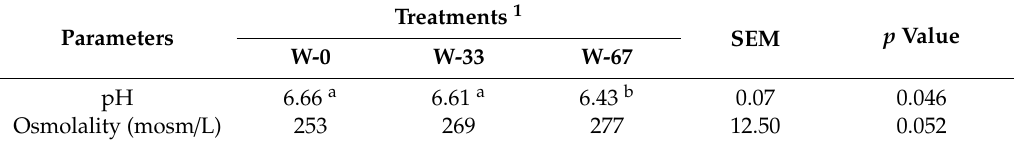
Table 5. Rumen liquor pH and osmolality in water-restricted male Najdi lambs fed a pelleted diet. Parameters